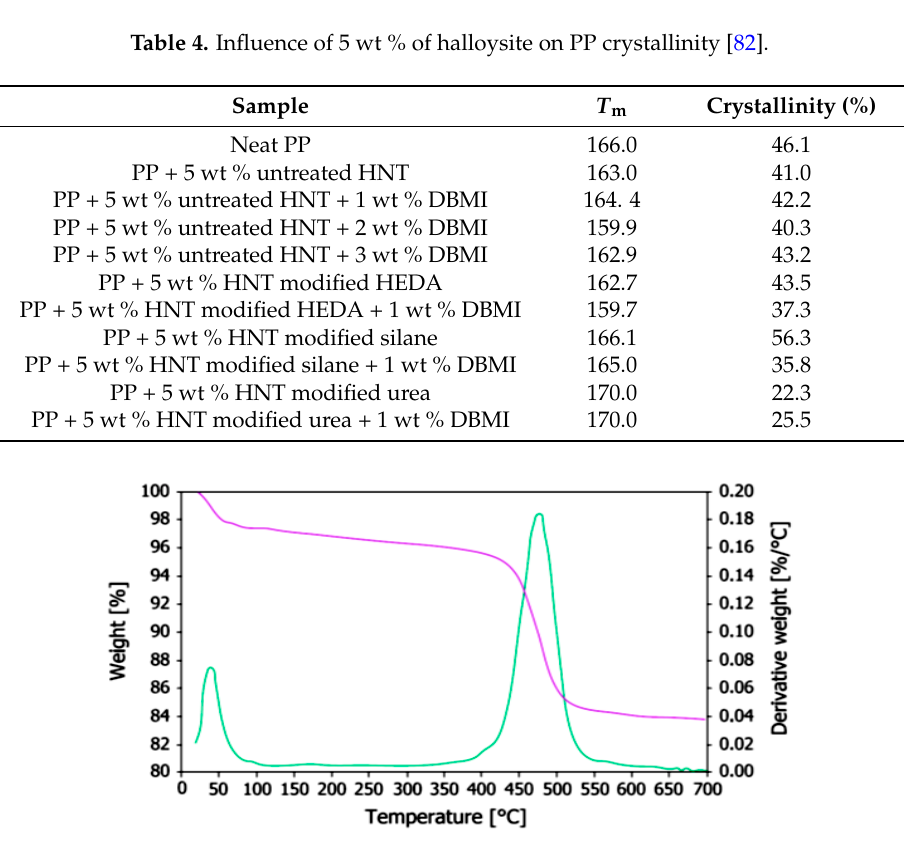
Figure 11. ( a ) Storage modulus ( G' ) and ( b ) complex viscosity ( η * ) as a function of frequency ( ω ) for pure PP and as-extruded PP/HNTs nanocomposites with different weight ratios [85].